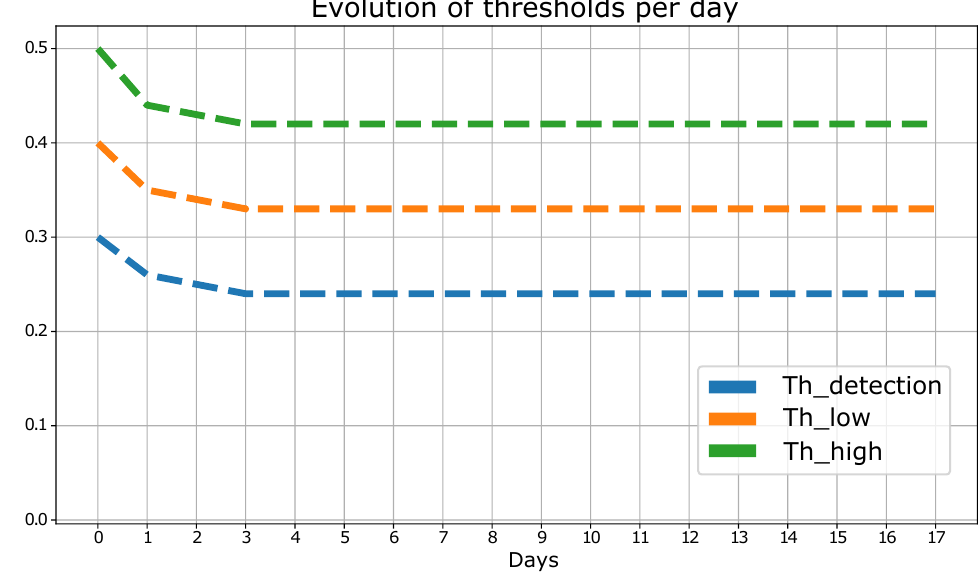
Figure 5. Evolution of detection algorithm